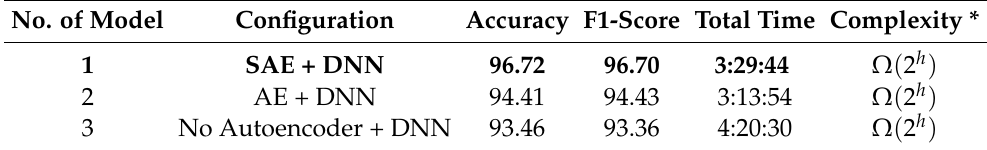
Table 10. Performance metrics for the cloneid _20 n data set.